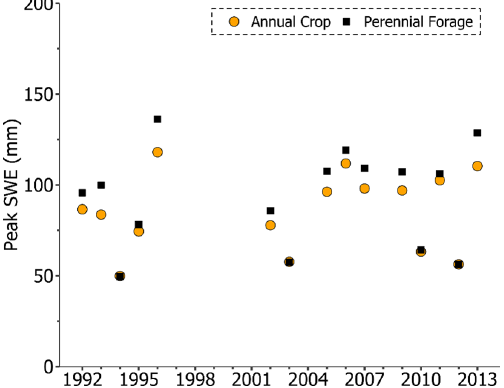
Figure 4. Comparison of peak daily discharge between annual crop and forage simulations for the La Salle River subbasin (LS- 05OG008). Error bars indicate the 95% confidence interval of the forage simulation ensemble. The years 1997–2001, 2004, and 2008 were not used for model assessment due to missing data or equip- ment malfunctions.